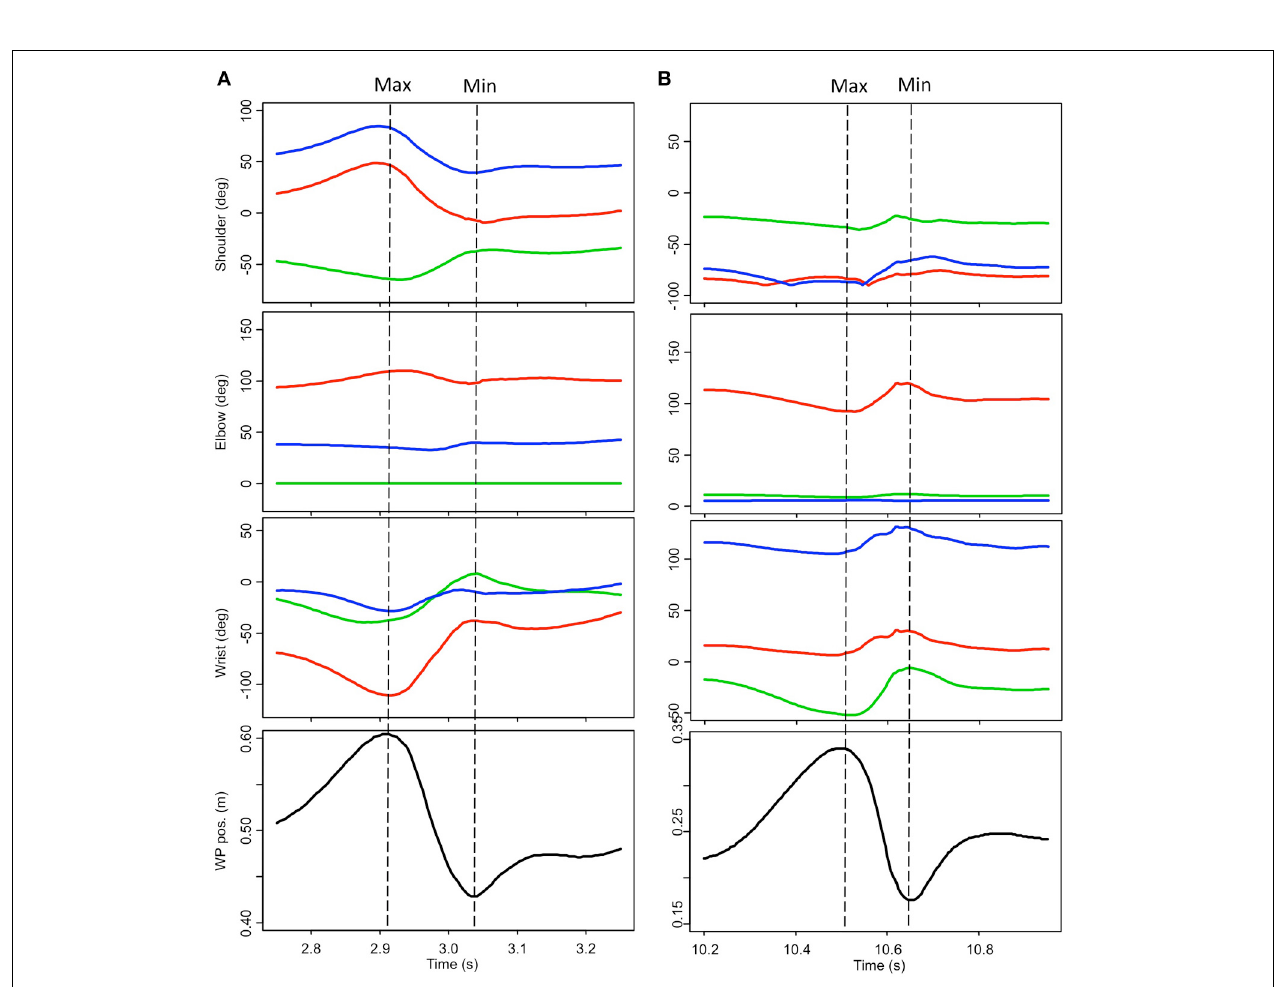
FIGURE 7 | Angular variations of the striking arm for two expert stone knappers during the successful removal of a stone flake. (A) P18-JL strike 2. (B) P19-BM strike 2. All joint values are given in degrees; Flex/Ext (red); Add/Abd (green); Rot Int/Ext (blue). Movement